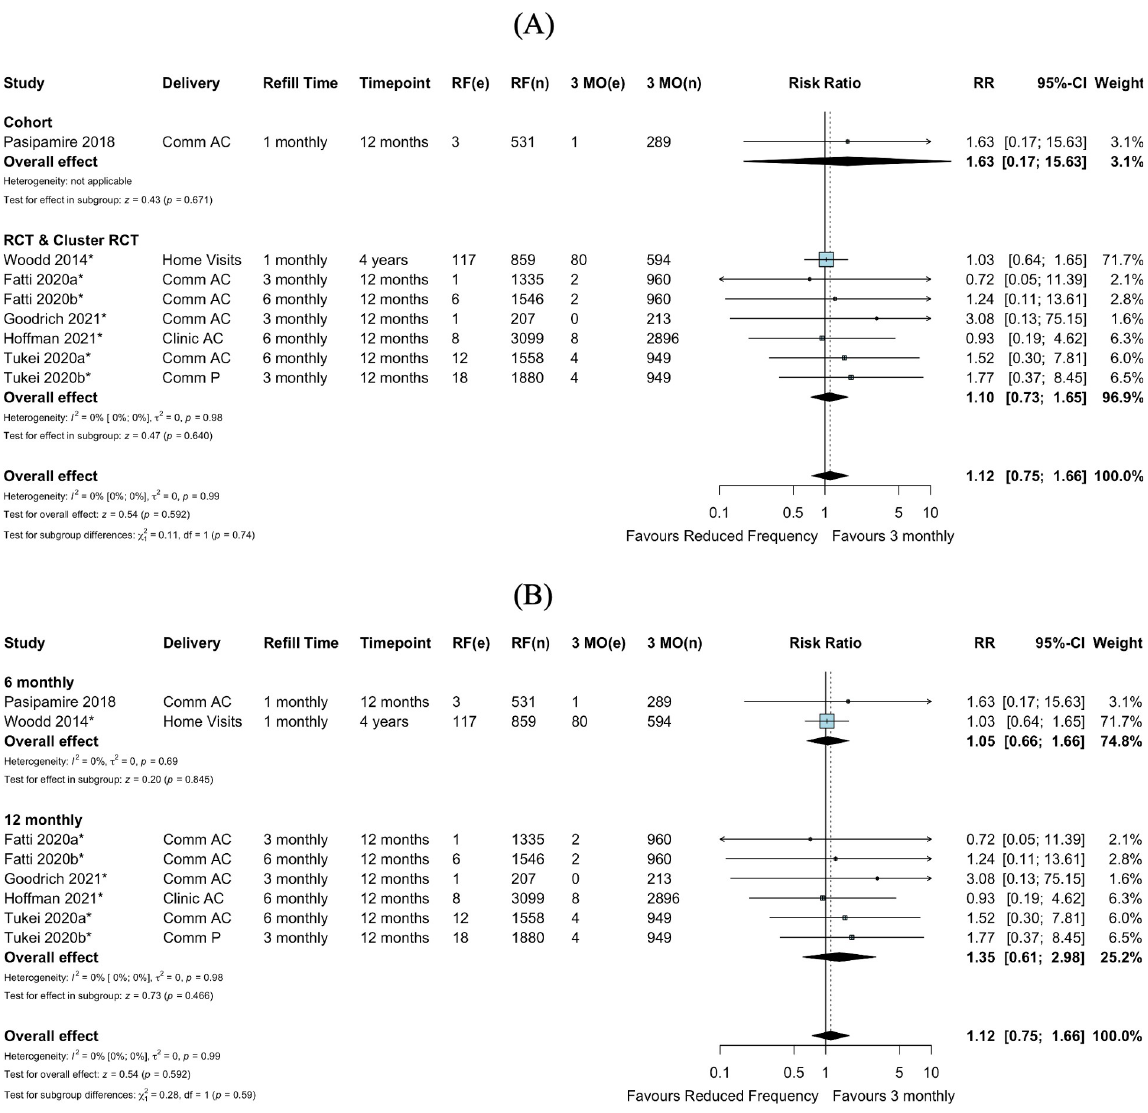
Fig 6. Mortality: Reduced frequency versus 3-monthly clinical consultations among randomized or enrolled individuals. (A) By study design. (B) By clinical consultation frequency. � Cluster-adjusted RR. 3 MO, 3-monthly; AC, adherence club; Comm, community; e, number of events; n, number of participants; P, pharmacy; RCT, randomized controlled trial; RF, reduced frequency; RR, risk ratio.